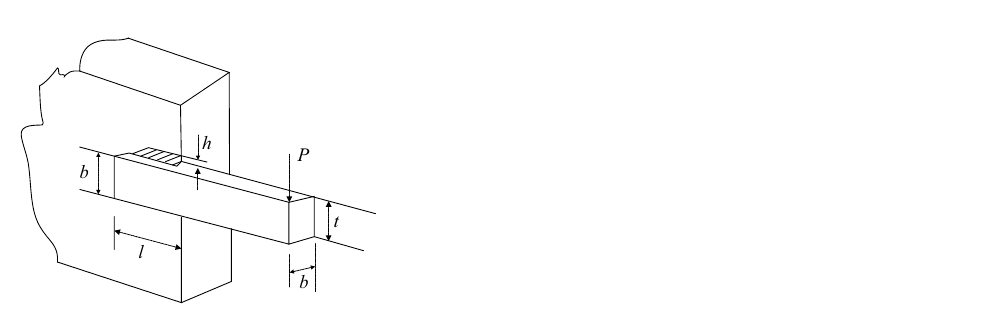
Figure 12. Welded beam